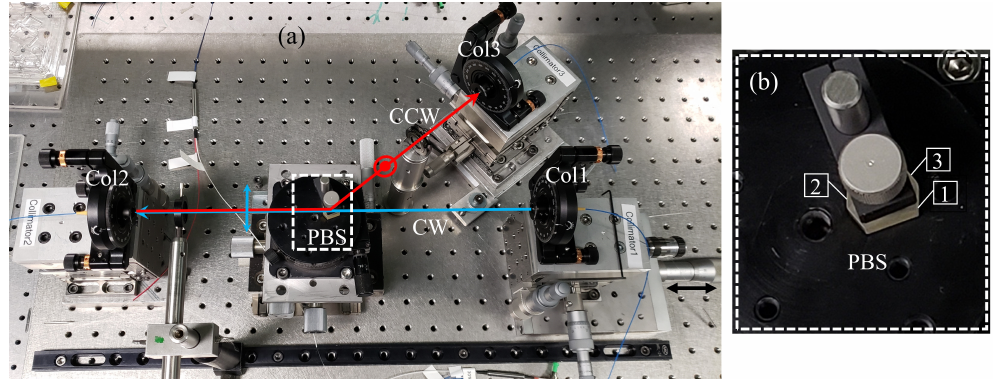
Figure 3. ( a ) The experimental setup of the free-space part of the orthogonally polarized ring fiber laser to separate the two orthogonal polarizations. Col: collimator, PBS: polarizing beam splitter. ( b ) The magnified picture of the PBS with the three optical faces